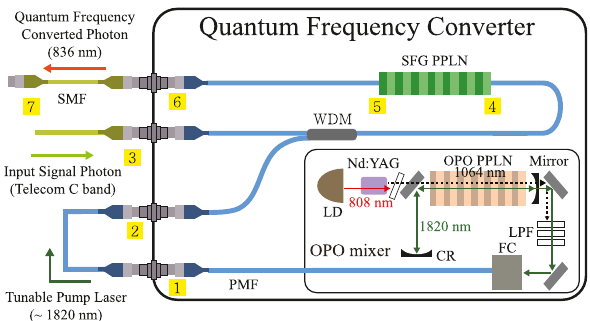
Figure 1: The structure of the quantum frequency converter (QFC) based on the sum-frequency generation (SFG) process. The laser diode of the optical parametric oscillator (OPO) mixer generates 808 nm light (red), converting it into 1064 nm (dashed) at the Nd:YAG crystal. This light produces both the light near 1820 nm (green) and 2560 nm by the OPO processes. The 1064 nm light is filtered through long-pass filters, and the 2520 nm light is intrinsically filtered from the 1550 nm fiber. The pump light generated near 1820 nm is combined with the telecom photons through the wavelength-division multiplexing (WDM) and transmitted to the periodically poled lithium niobite (PPLN) waveguide for generating the 836 nm converted photons by an SFG process. The numbers in the yellow square boxes are the path information for Table 1. LD: laser diode, SFG PPLN: SFG